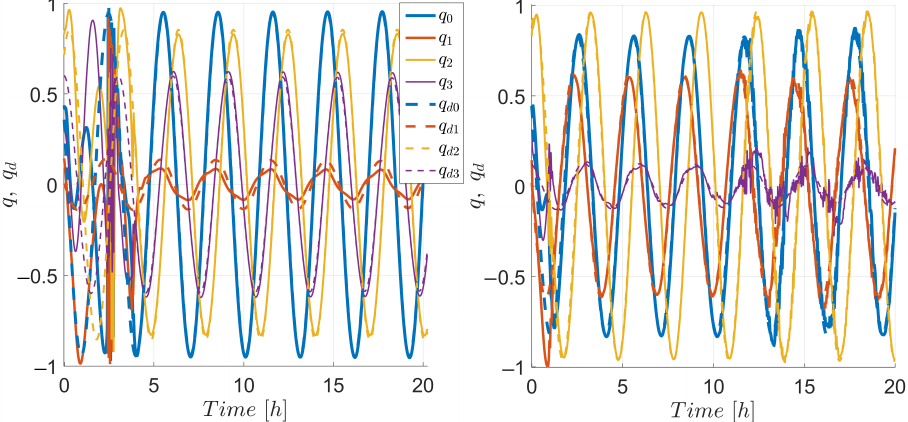
Figure 6. Quaternions q and q d for the target ( left ) and chaser ( right ), first 20 h of simulation.